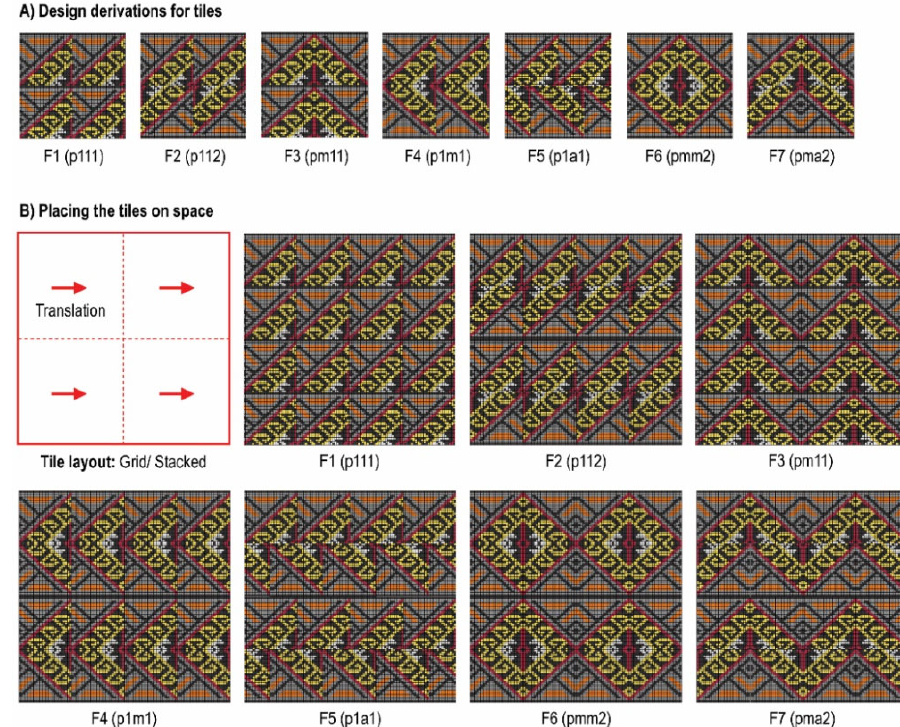
Figure 6. Asymmetric units and adjustments on a square tile. (Illustration by Kunkhet and Chud ‐ asri).